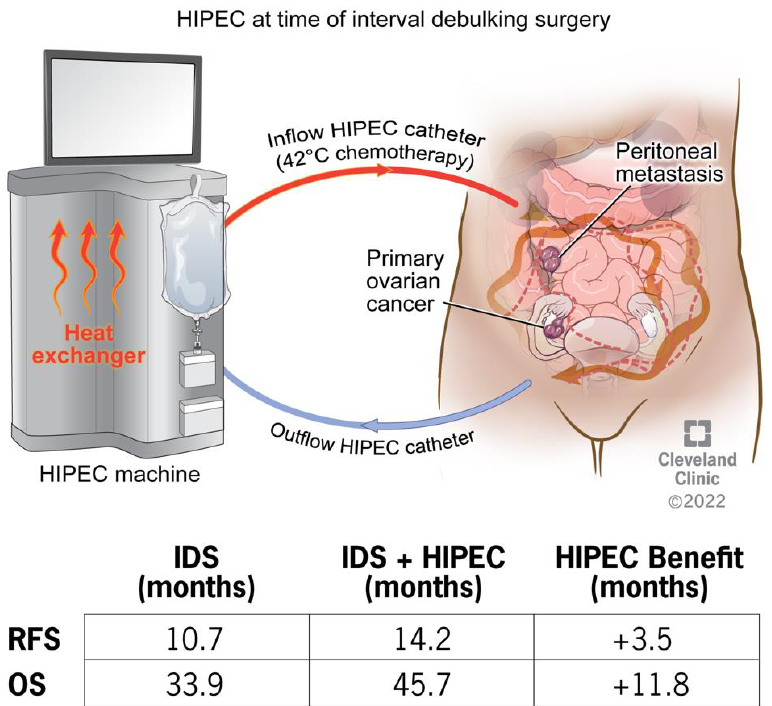
Figure 1. Hyperthermic Intraperitoneal Chemotherapy (HIPEC) treatment in a patient with primary ovarian cancer and peritoneal metastasis. HIPEC has shown an overall survival benefit of nearly 12 months and a regression-free survival benefit of 3.5 months compared to standard of care alone. Reprinted with permission, Cleveland Clinic Foundation © 2022. All Rights Reserved.